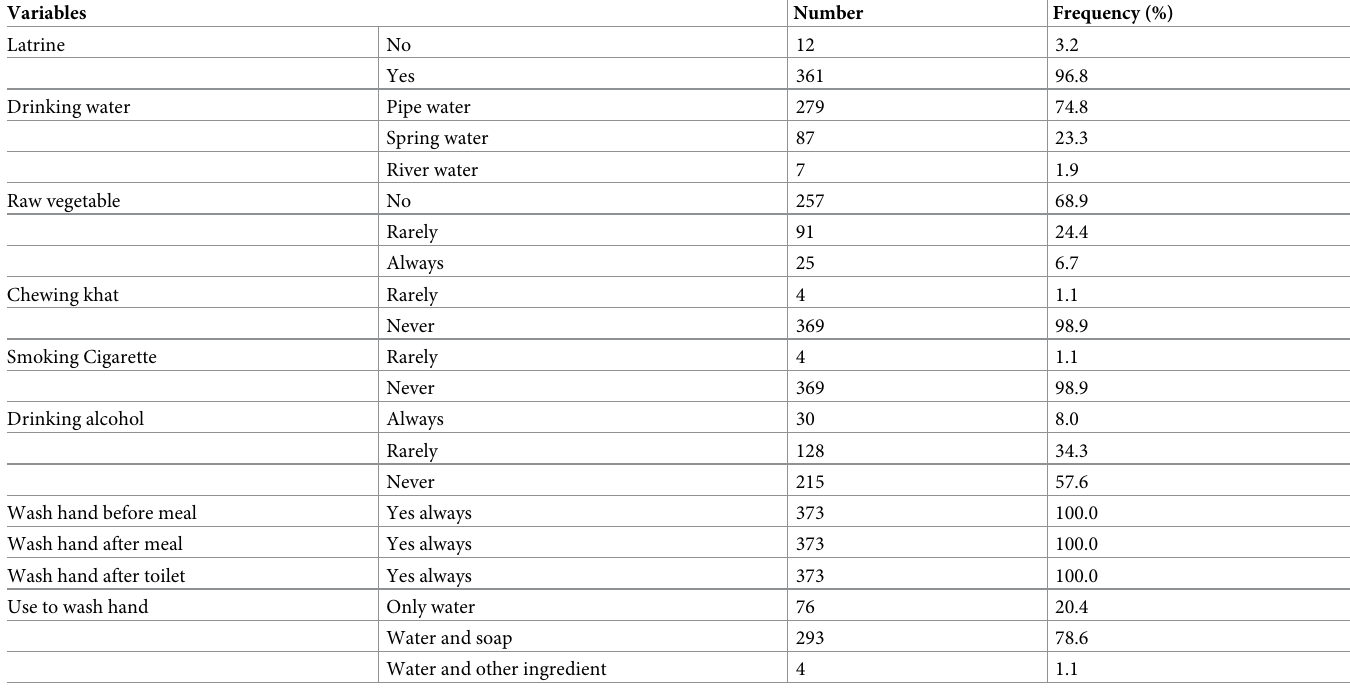
Table 2. Behavioral factor of study participants at DTCSH, Northwest Ethiopia, 2020.